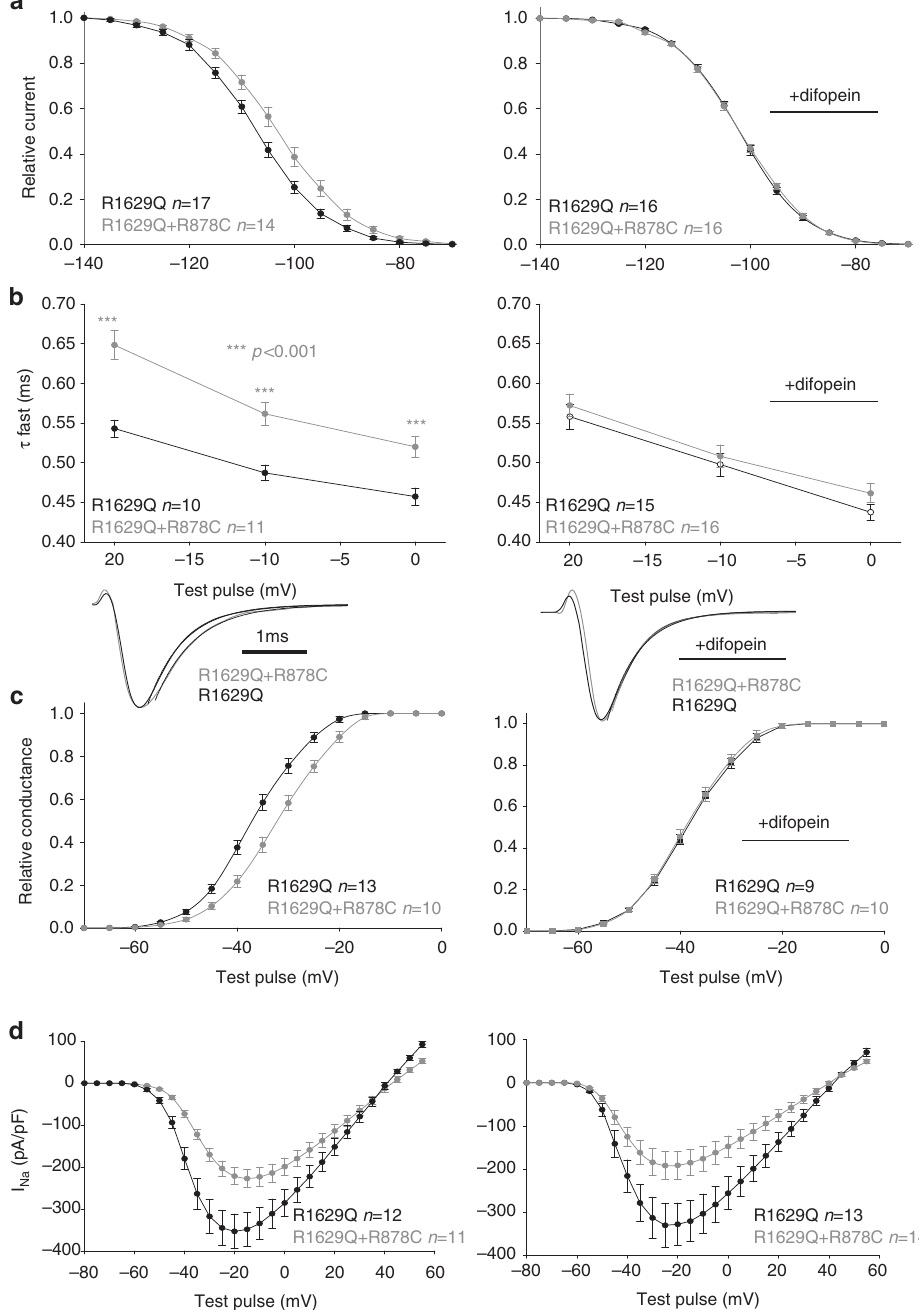
Fig. 6 Example of biophysical coupling between R1629Q and R878C mutants when co-transfected in HEK293 cells. a Steady-state inactivation. b Time constants of inactivation measured at the listed voltages. Bottom part shows representative examples of the fi t. c Voltage-dependent activation obtained using the conductance equation. d Current – voltage relationship, I/V curves. Left column without difopein, Right column in presence of difopein. Importantly, in presence of difopein we see uncoupling of the steady-state inactivation, time constants of inactivation and voltage-dependent activation. Data are presented as mean ± SEM *** p <